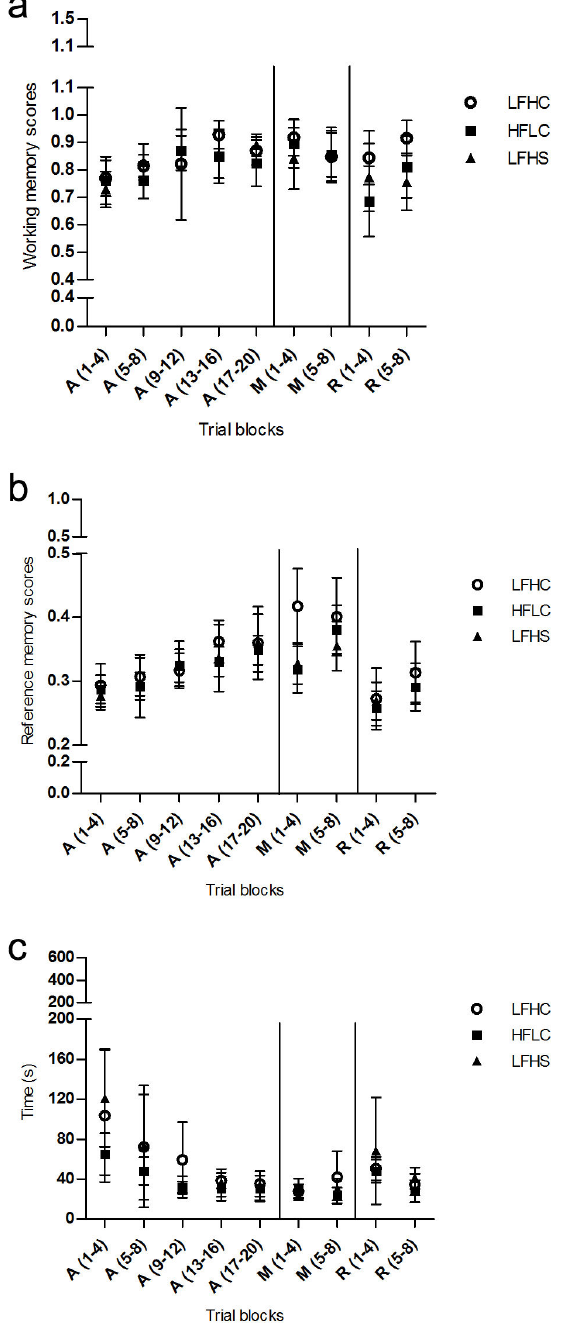
Figure 1. a-c. Performance of minipigs in the spatial hole- board discrimination test. . Data are presented as trial blocks of means of four trials ±SD for the acquisition phase (A), the memory phase (M) and the reversal learning phase (R) where a = working memory scores, b = reference memory scores and c = trial duration (time, sec.). Low fat, high carbohydrate diet (LFHC); high fat/cholesterol, low carbohydrate diet (HFLC); low fat, high carbohydrate/sucrose diet (LFHS).